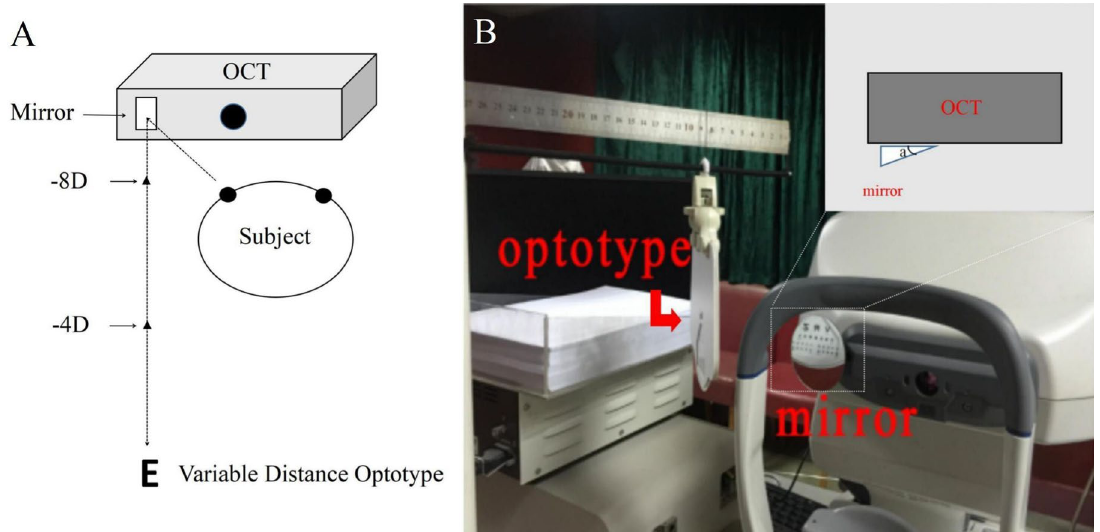
Figure 1. ( A ) Simulated diagram of the setup used to stimulate different accommodation during optical coherence tomography (OCT) imaging. A tilted mirror with a frame carrying a rotation axis was fixed on the OCT machine and used to place the stimuli at different vergences. The participants were instructed to stare at the optotypes through the mirror with their left eye, and right eye was covered with a gauze. Then, the left eye was imaged by OCT. ( B ) According to the individual interpupillary distance and testing items adjusted the tilting angle a of the